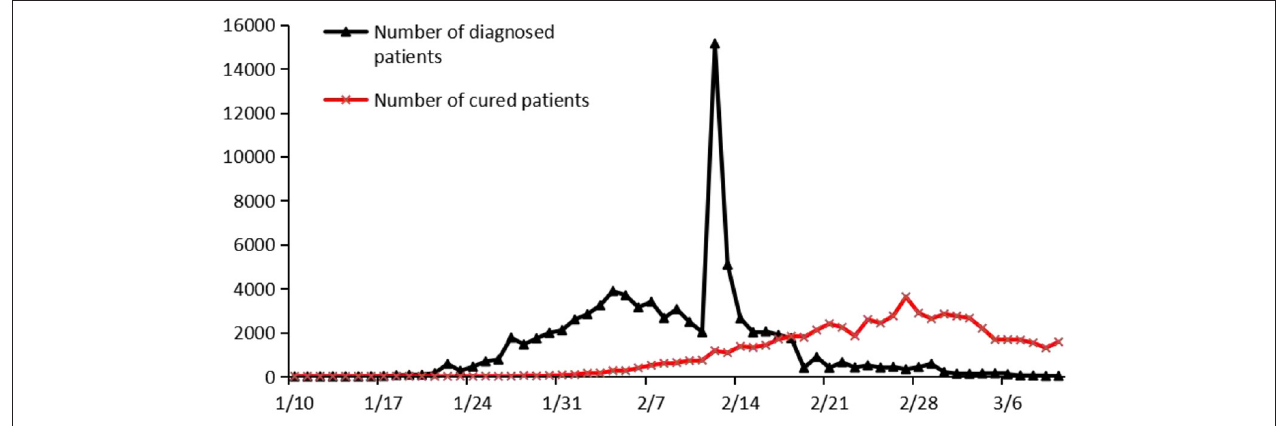
FIGURE 1 | Daily number of diagnosed patients and people cured in